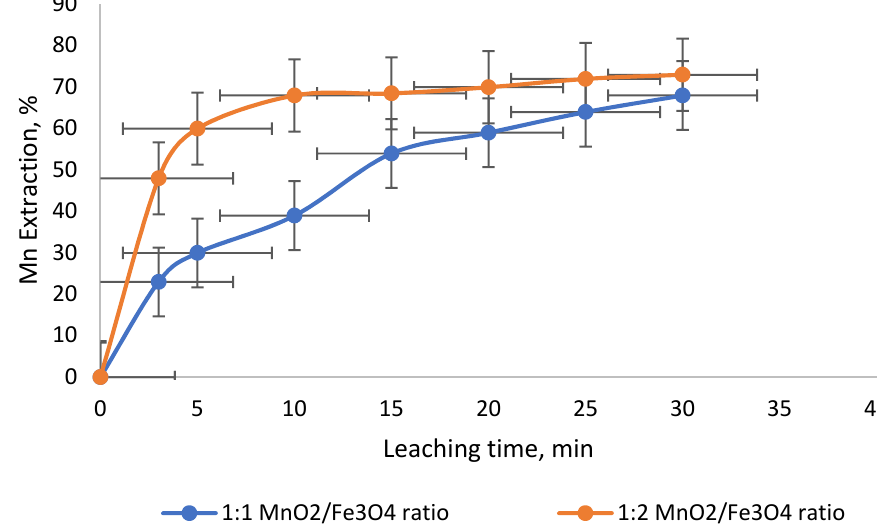
Figure 4. Manganese dissolution from black copper minerals at different ratios of MnO 2 /Fe 3 O 4 and 1 mol/L H 2 SO 4 .